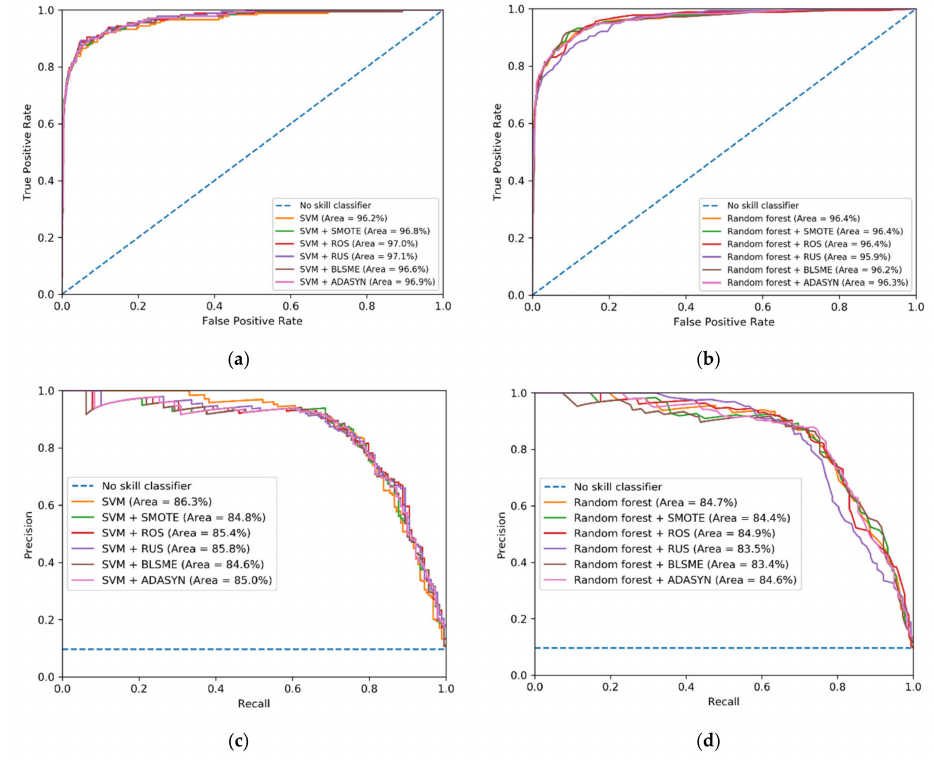
Figure A11. The ROC and PR curves of SVM and Random Forest for Fold 10; ( a ) the ROC curve of SVM; ( b ) the ROC curve of Random Forest; ( c ) the PR curve of SVM; and, ( d ) the PR curve of Random